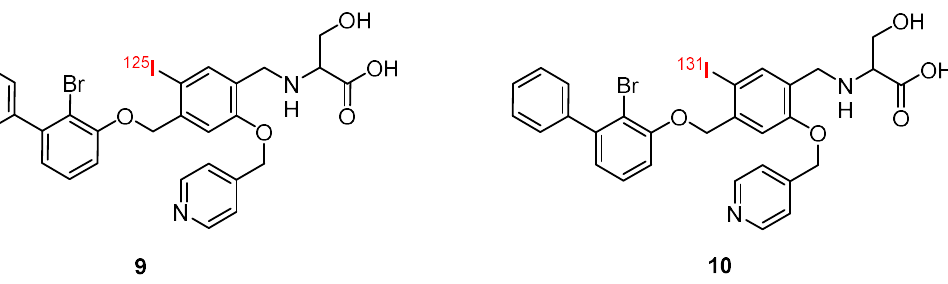
Figure 14. Examples of radioiodinated small molecule PD-L1 inhibitors for diagnostic ( 9 ) and therapeutic ( 10 ) applications [125].